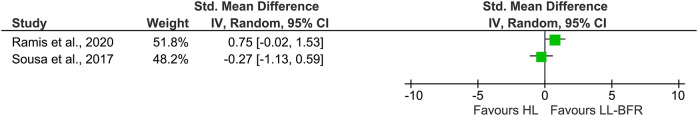
Forest plot illustrating the standardized mean differences of two studies describing the effects of HL (Left) and LL-BFR training (Right) on muscle excitation using a parallel group design. The pooled effect size was not included due to a high heterogeneity. CI, confidence interval; HL, high-load; IV, inverse variance; LL-BFR, low-load blood flow restriction; Random, random effects model.